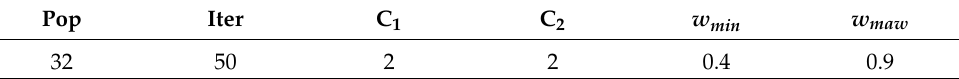
Table 5. PSO parameters.